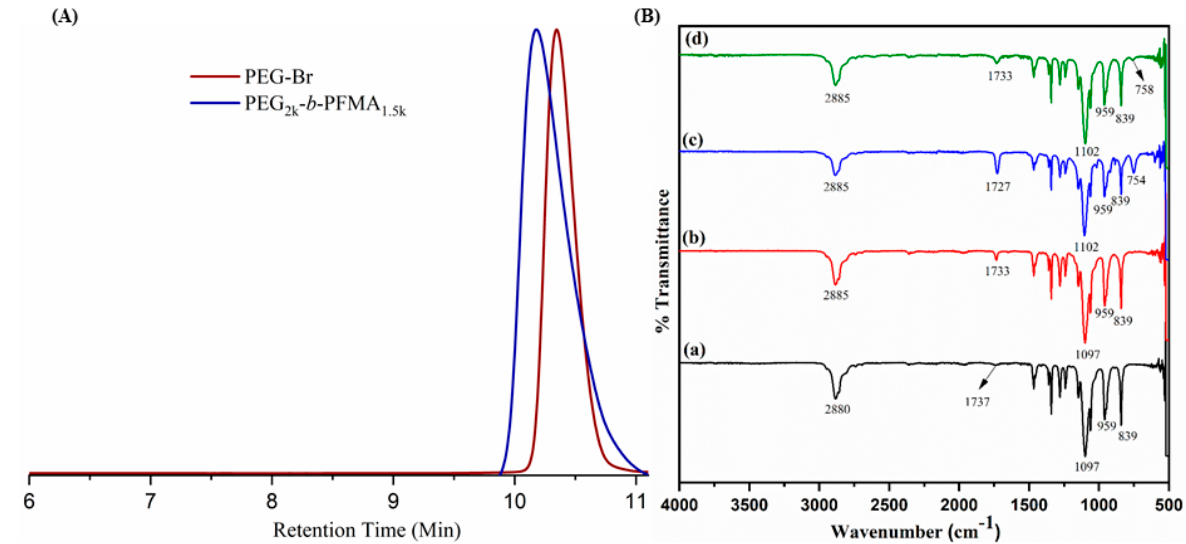
Figure 3. GPC chromatograms of the PEO 2k -Br macro-initiator and PEO 2k - b -PFMA 1.5k copolymer ( A ), FTIR spectra of (a) PEO 2k , (b) PEO 2k -Br, (c) PEO 2k - b -PFMA 1.5k , and (d) CCL ( B ).